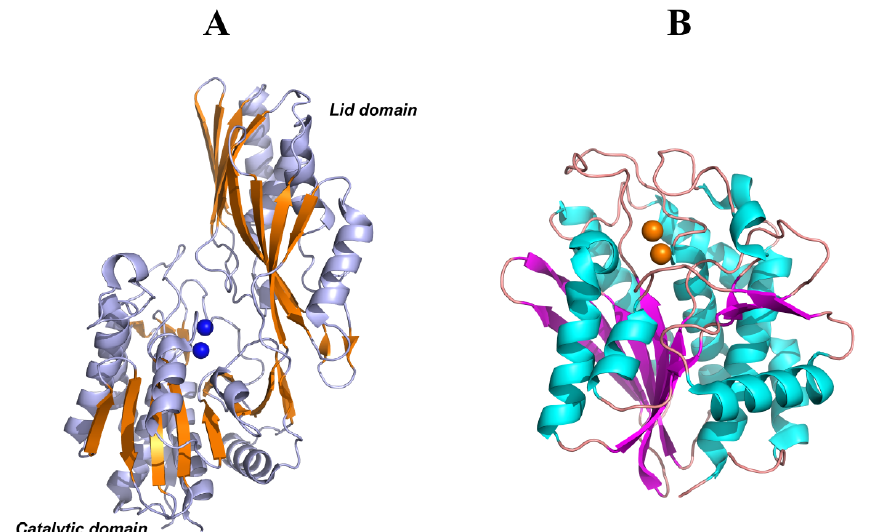
Figure 6. ( A ) Ribbon diagrams of PepV, in which β -sheets of the catalytic and lid domains are highlighted in yellow and the two catalytic zinc ions of the active center are represented as blue spheres. ( B ) Ribbon diagrams of AAP, in which β -sheets of the only catalytic domain are highlighted in magenta and the two catalytic zinc ions of the active center are represented as yellow